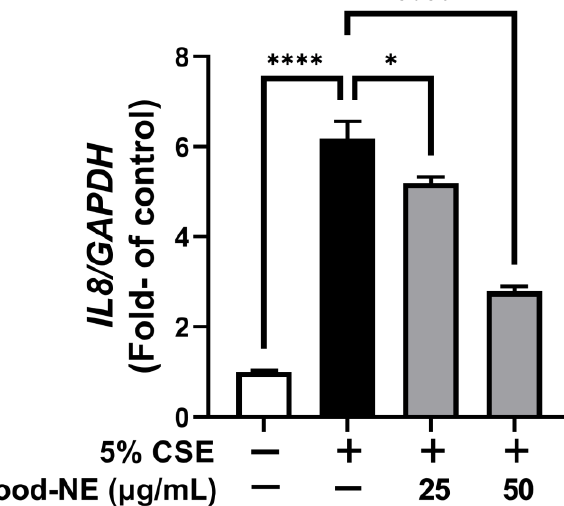
Figure 2. Effect of Agarwood-NE on the CSE-induced transcription of the pro-inflammatory cytokine IL-8. BCi-NS1.1 cells were pre-incubated for 1 h in the presence of 25 and 50 µ g/mL agarwood-NE, followed by exposure to 5% CSE for 24 h. The mRNA levels of IL-8 were determined via RT-qPCR. Values are expressed as mean ± SEM ( n = 4, *: p < 0.05; ****: p < 0.0001).